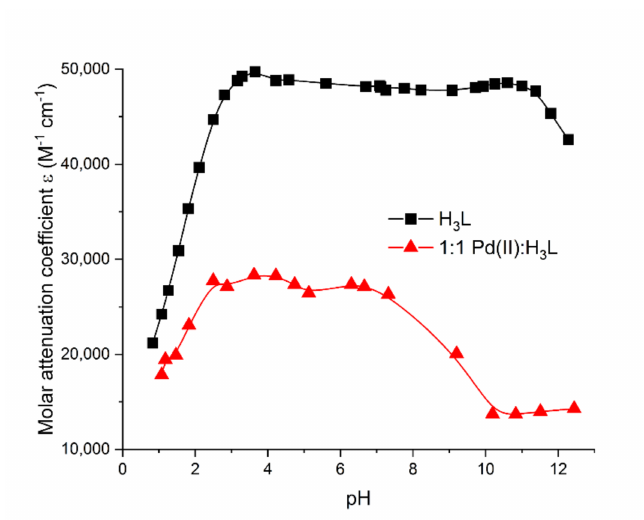
Figure 4. Measured molar attenuation coe ffi cient of the 328 nm band of H 3 L alone (black) or in the presence of 1 eq of Pd(II) (red). Complex formation is observed in the whole explored pH range.